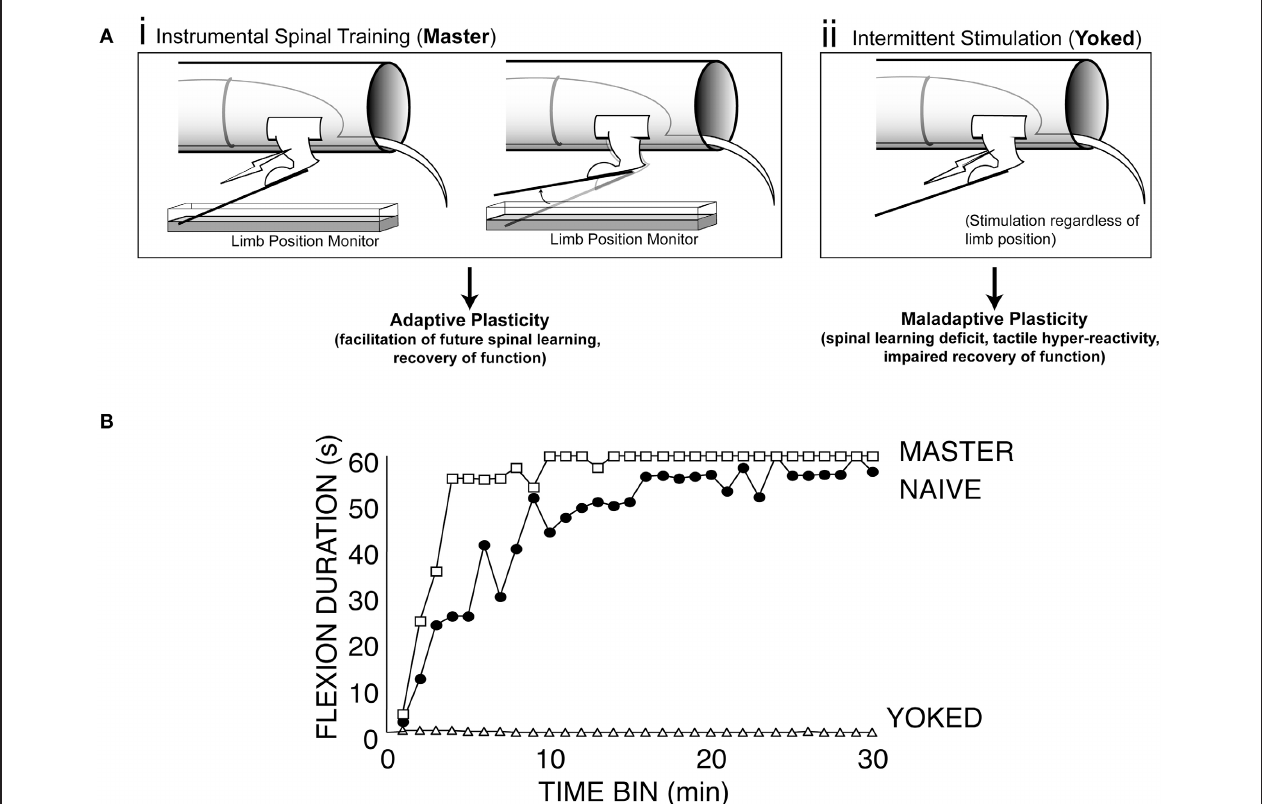
The yoked rats receive stimulation whenever the master does, regardless of their hindlimb position. (B) Exposure to this uncontrollable (yoked) stimulation causes a learning deficit that is evident when these rats are later tested with the spinal learning assay. Spinal learning is assessed by monitoring the ability of spinally transected rats to maintain the hindlimb in a flexed position as manifested by increasing average response duration in each 1min time bin for 30min test during instrumental training. Modified from Grau et al.